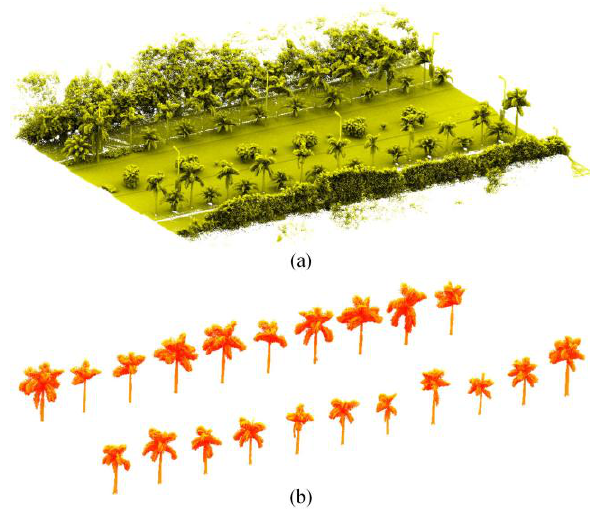
Figure 5. (a) Dataset I, and (b) extracted 3D trees.